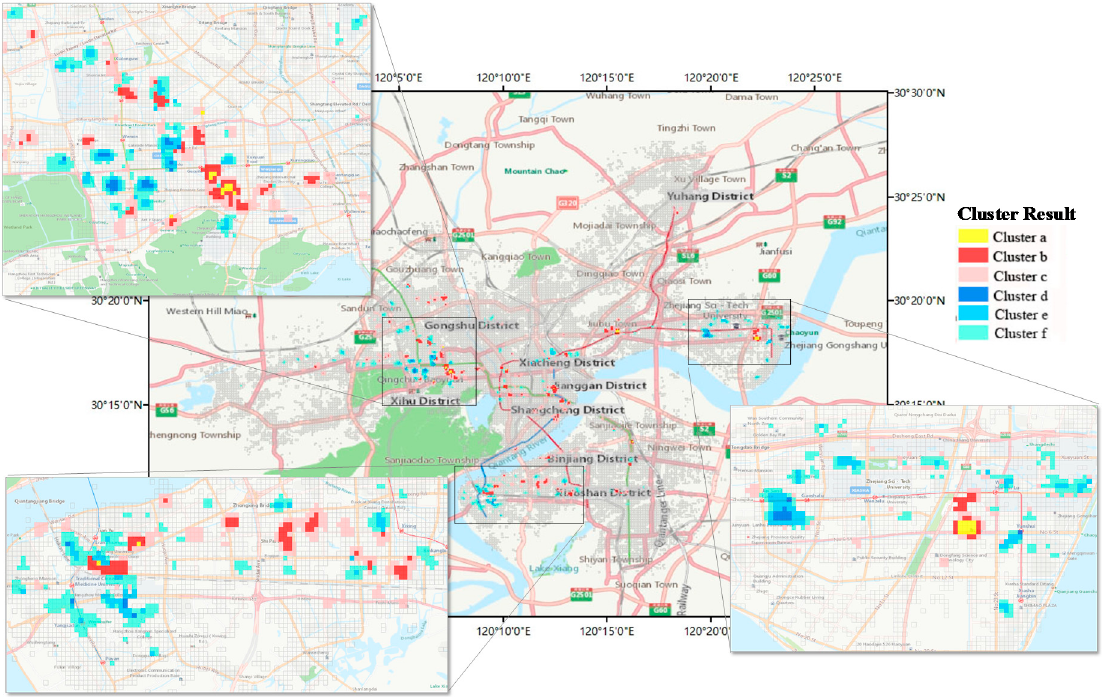
Figure 9. Grid distribution of the cluster results in the research area.